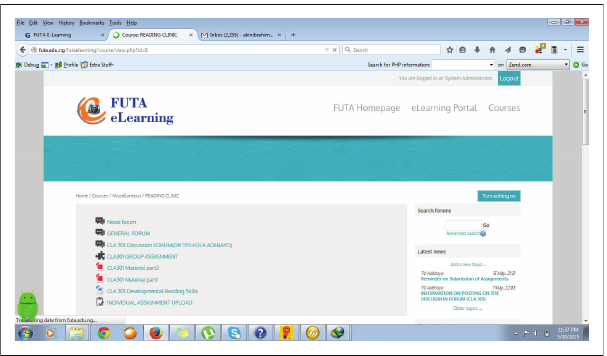
FIGURE 1-A1: Landing page of the FUTA e-learning